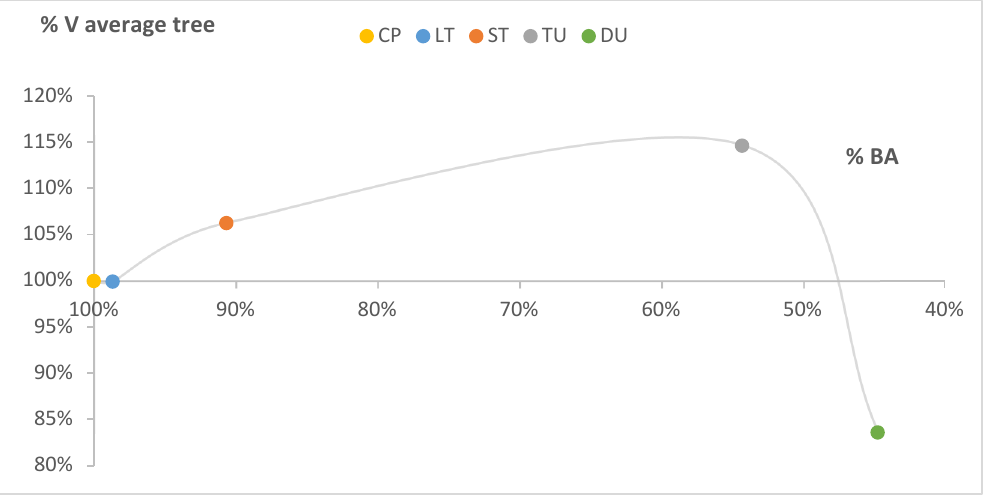
Figure 6. Unitary volume variation V of the average tree in 2019 expressed as a percentage of the volume of the mean tree of the control plots (100%) with respect to the BA expressed as a percentage of the CP BA (100%).